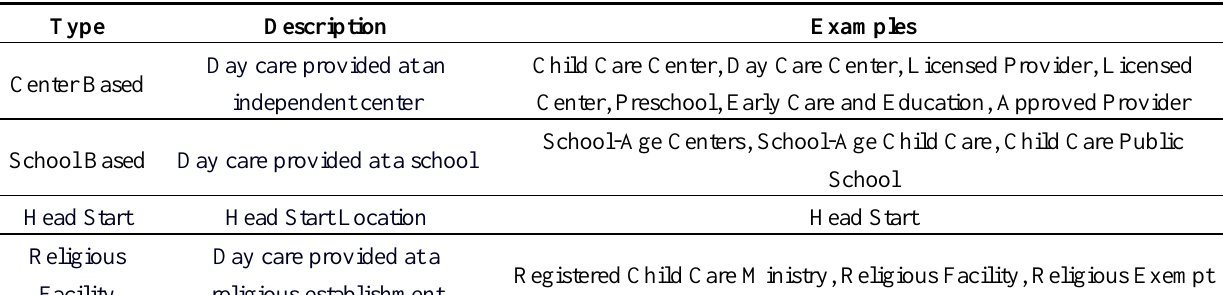
Table 3. Classification of day care